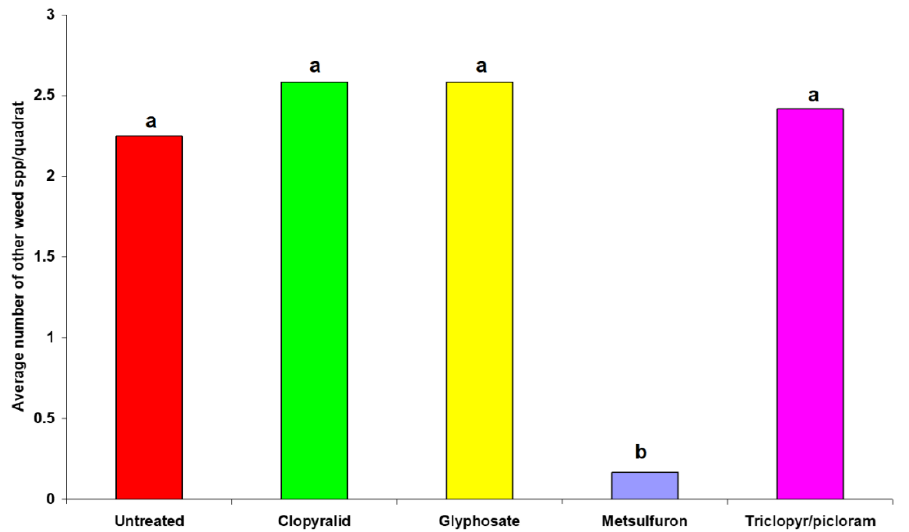
Figure 3. Average number of weeds per m − 2 for a double pass 3 months after wiper application of herbicides. Means followed by the same letter are not significantly different (LSD, p < 0.05).